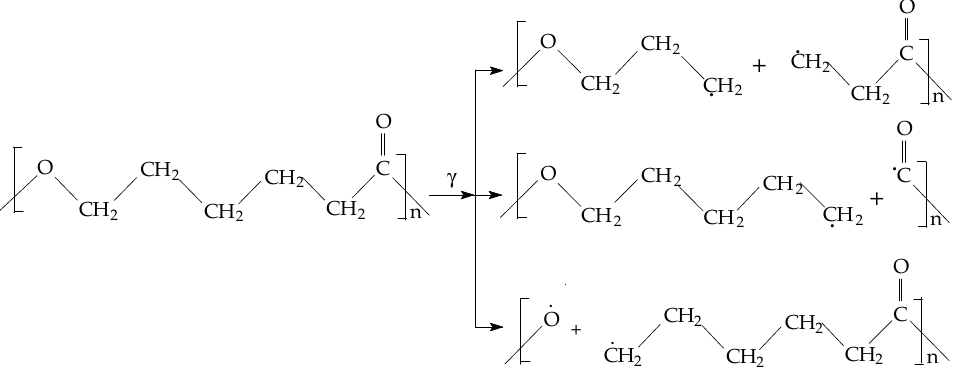
Figure 9. The proposed methods for the formation of free radicals by γ -irradiation.